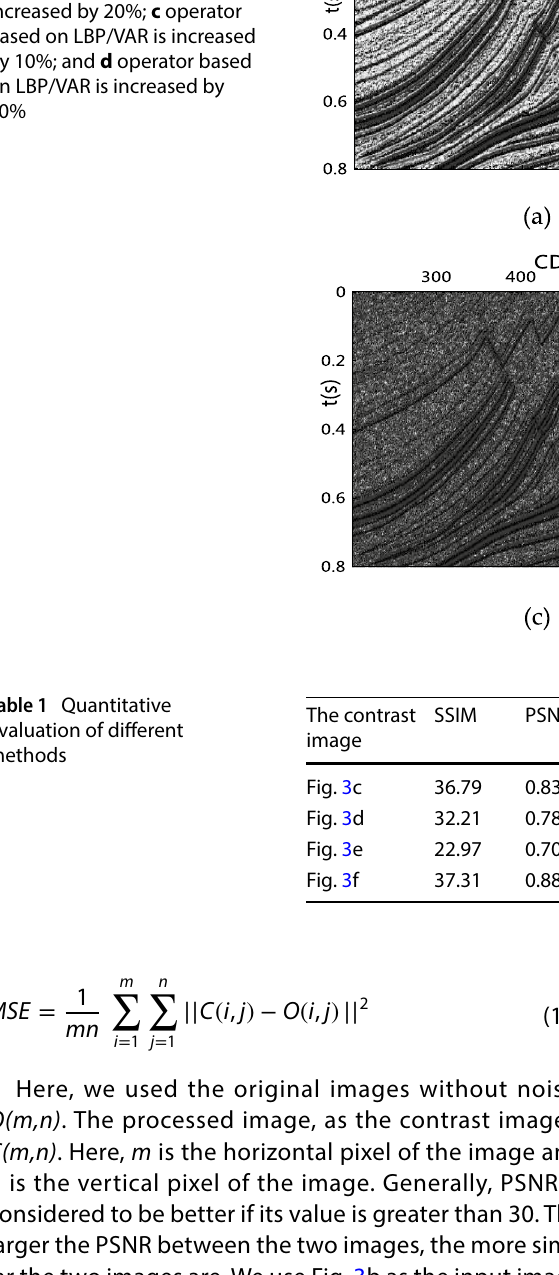
Fig. 4 Results of the Marmousi model added noise test. a Operator based on guided filter-LBP/VAR is increased by 10%; b operator based on guided filter-LBP/VAR is increased by 20%; c operator based on LBP/VAR is increased by 10%; and d operator based on LBP/VAR is increased by